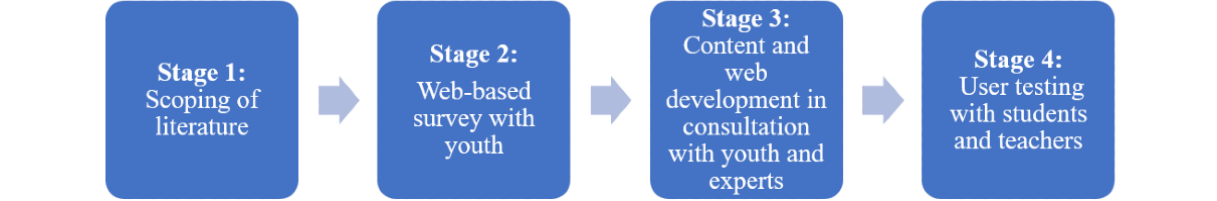
Figure 1. Co-design of the Health4Life school-based program.